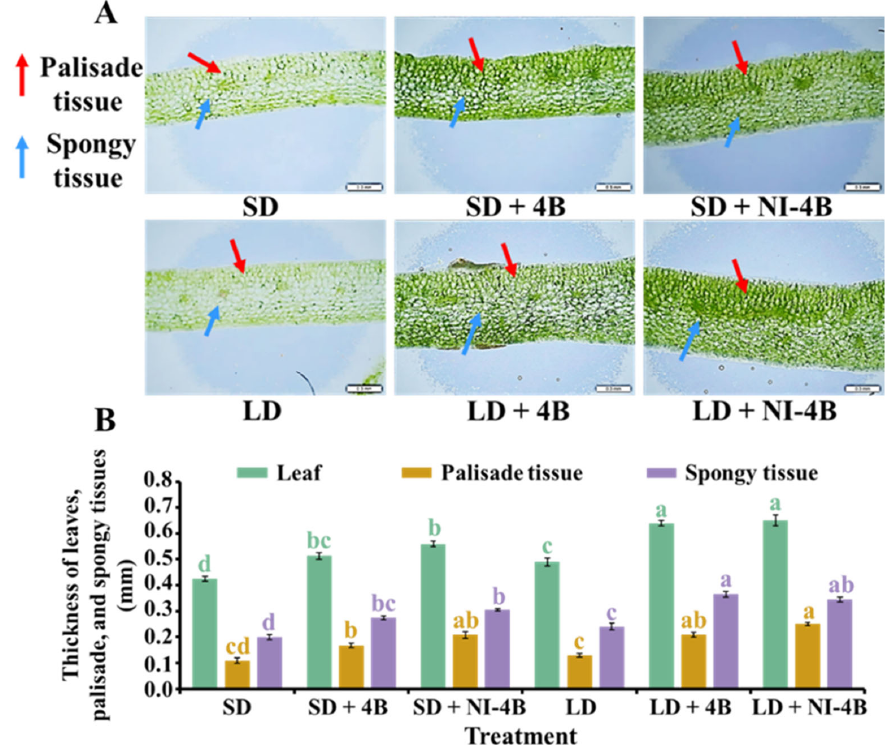
Figure 4. The effects of the supplementary and night ‐ interrupting 10 μ mol ∙ m − 2 ∙ s − 1 PPFD B light on the anatomical features of kalanchoe ( Kalanchoe blossfeldiana ‘Rudak’) leaves, after 60 days of exposure to the photoperiodic light treatments: the micrographs ( A ); and analysis charts ( B ) of leaf structures. Bars indicate 0.3 mm. Vertical bars indicate the means ± standard error ( n = 6). Different low ‐